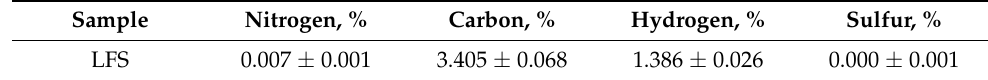
Table 1. Elemental analysis of ladle furnace slag.